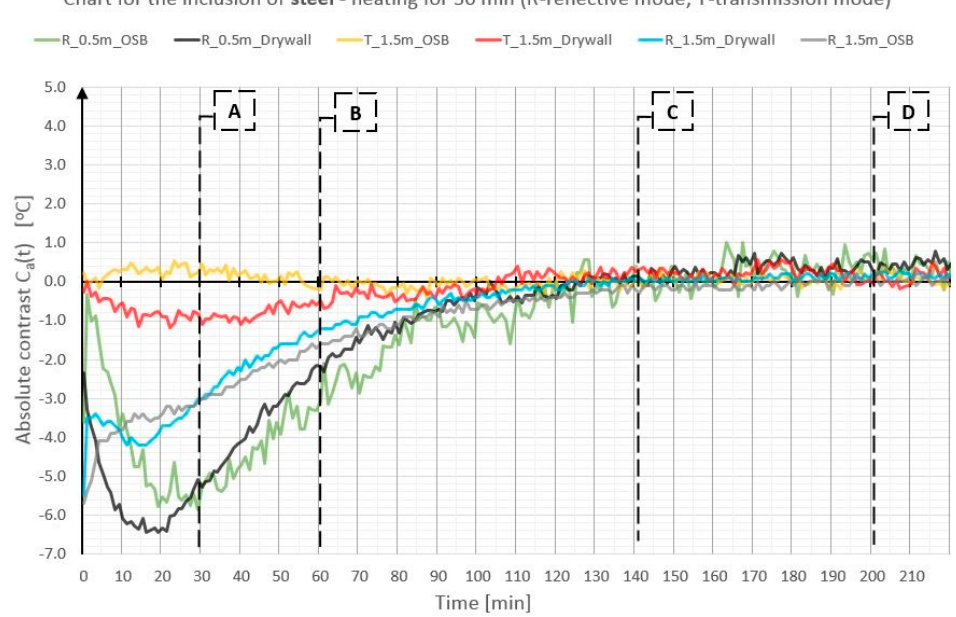
Figure 12. Comparison of absolute contrasts in a reflection mode and in a transmission mode for material inclusion made of steel.